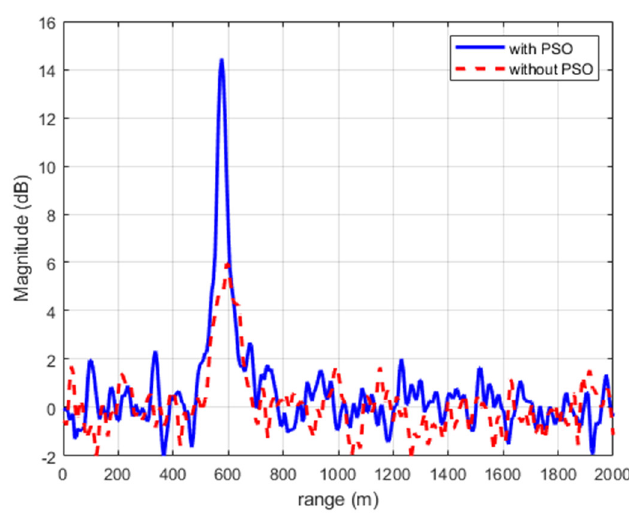
Figure 13. Range profiles of the final integrated results.